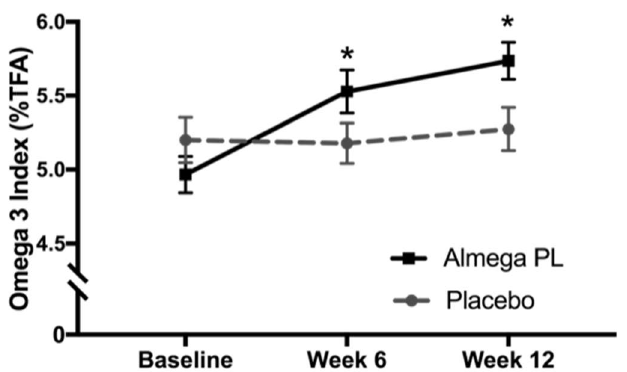
(Table 2). DHA and ARA in red blood cells did not change in either treatment group (Table 2).